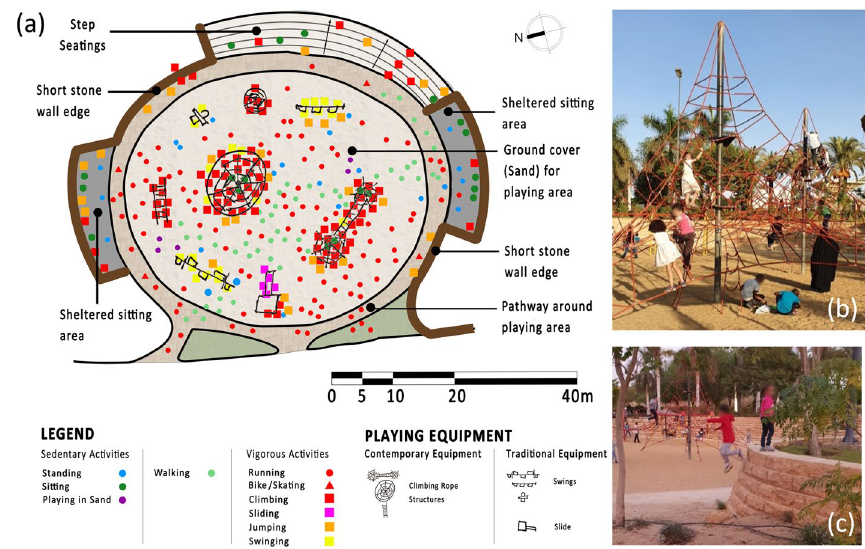
Fig. 9 PG1, combined behavior map and